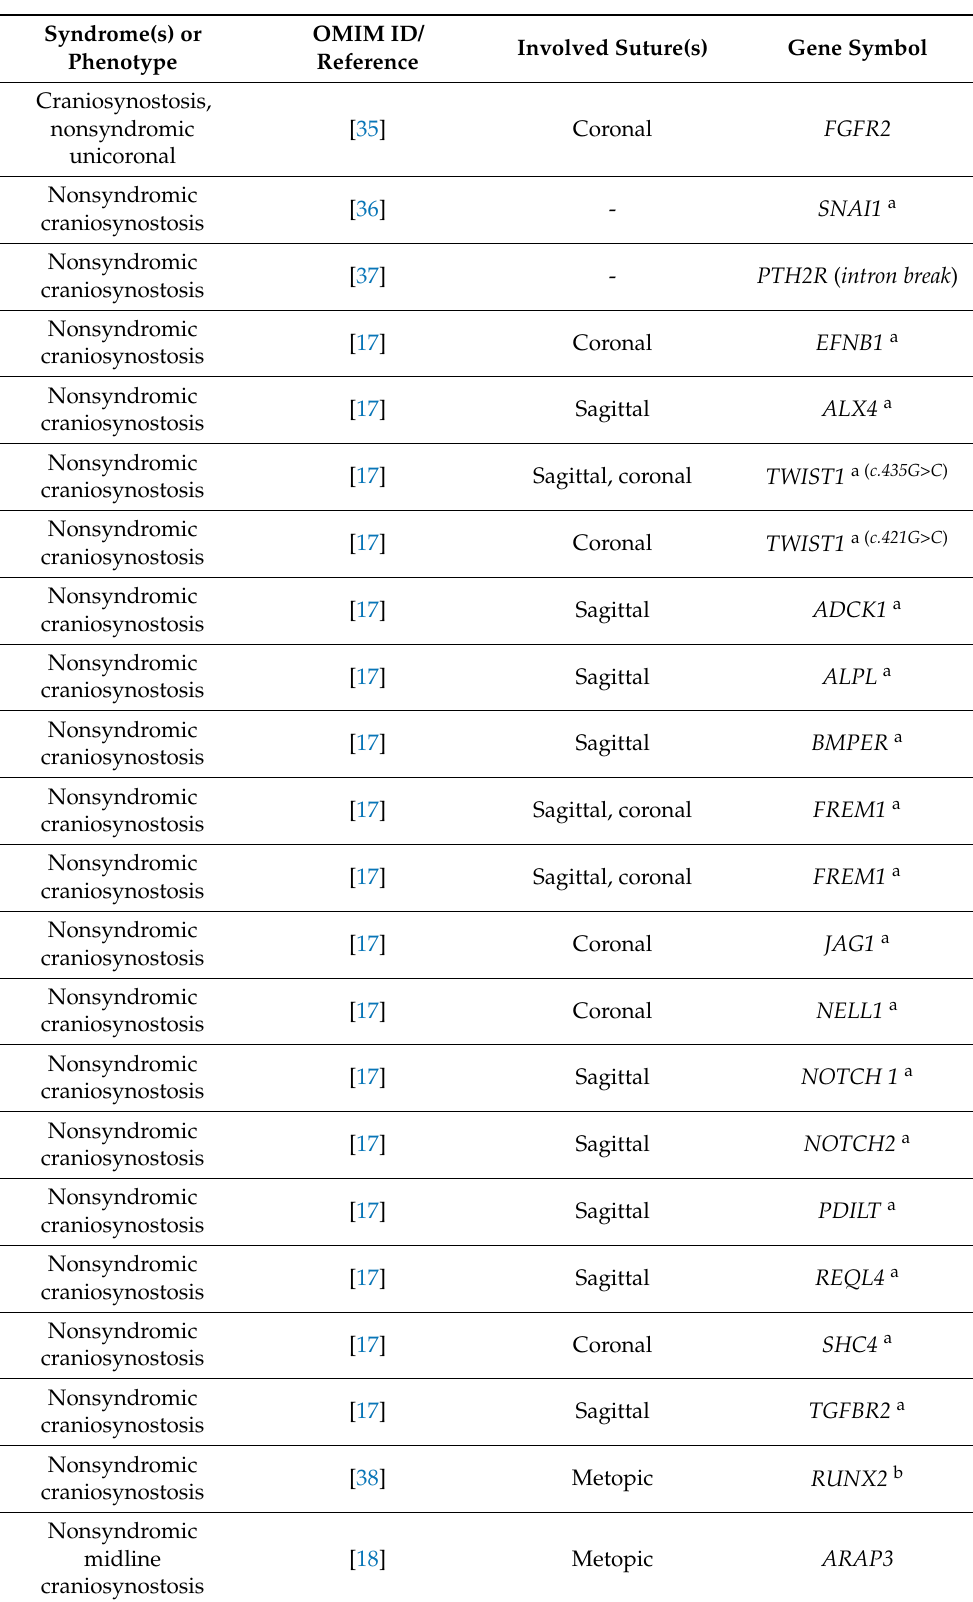
Table 2. Nonsyndromic Craniosynostosis and associated